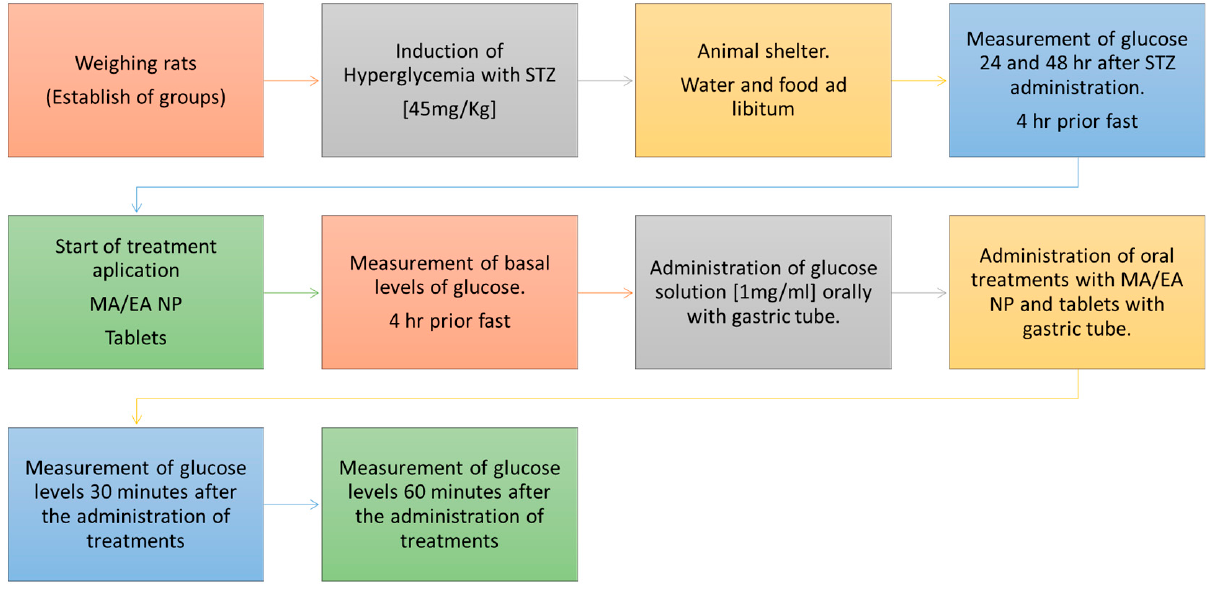
Figure 4. Application of treatments and determination of blood glucose levels.